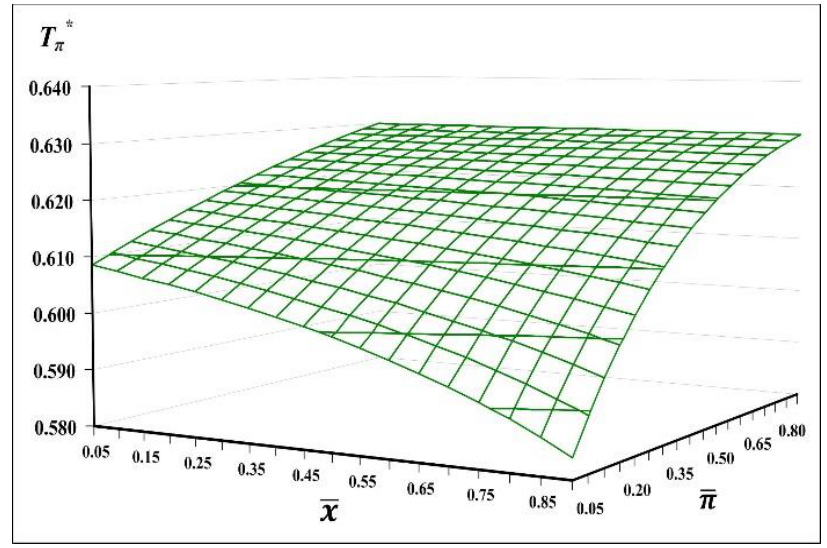
Figure 11. Joint impacts of changes in x and  on the optimal cycle time T π